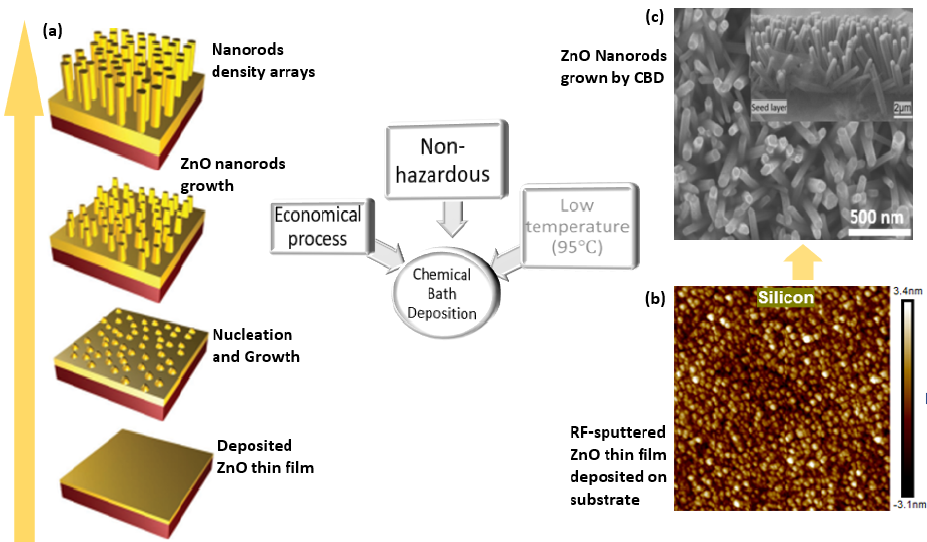
Figure 7. Schematic illustration of ( a ) ZnO seed layer deposition, followed by ZnO nanorod arrays synthesized by chemical bath method assisted ( b ) sputtered ZnO seed layer deposited on the substrate ( c ) FESEM image of ZnO nanorods grown using CBD. Reprinted with permission from ref. [89]. Copyright 2021 Elsevier. Reprinted from ref.